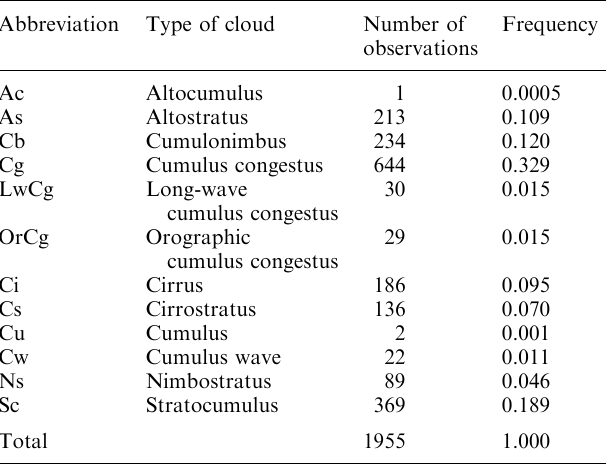
Table 2. Number of observations for each type of